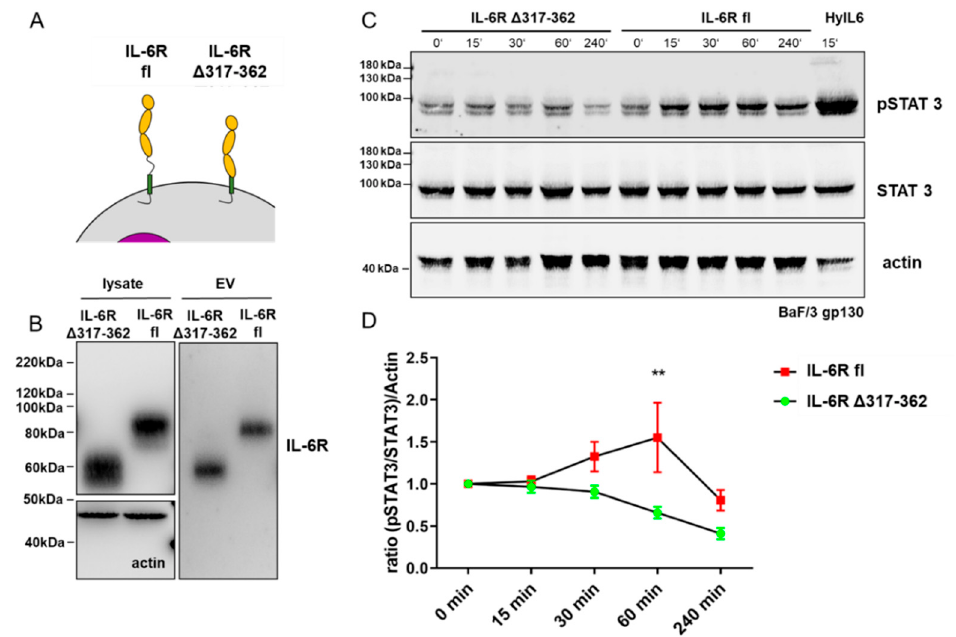
Figure 3. EVs containing IL-6R induces STAT3 (Signal Transducer and Activator of Transcription 3) phosphorylation (Tyr705). ( A ) Schematic presentation of full-length IL-6R (IL-6R fl) and a variant lacking the stalk region of the IL-6R (IL-6R ∆ 317-362). This variant was previously shown to be inactive with regard to signal transduction [38]. ( B ) Western blot analysis of cell lysate and isolated EVs carrying the full-length IL-6R (IL-6R fl) and the IL-6R missing the stalk region (IL-6R ∆ 317-362). The deletion variant migrates at a lower molecular mass, due to the removal of the stalk region. ( C ) Timeline experiment in BaF / 3 gp130 expressing cells. These cells depend on the IL-6R and IL-6 for Stat3 phosphorylation (pSTAT3). HyperIL-6 (HyIL6), a chimeric protein of IL-6 and soluble IL-6R, was used as a positive control. Only EVs carrying the wild-type (WT) IL-6R (IL-6R fl) induces STAT3 phosphorylation. D ) Quantification of five independent experiments (as in C) reveals a significant